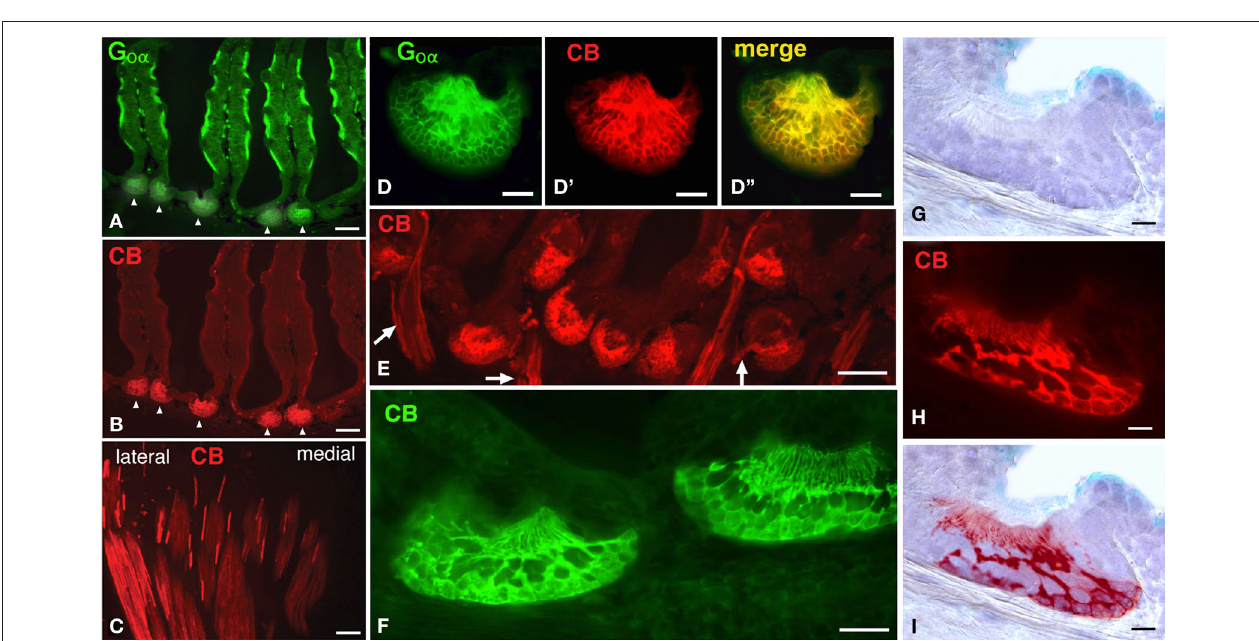
Figure 3 | The olfactory epithelium of the lamellae is gi α 2- immunoreactive but the crypts only show go α -immunoreactivity. (A) Gi α 2 immunoreactivity in the lamellar epithelium (arrowheads) and lack of reactivity in the basal crypts